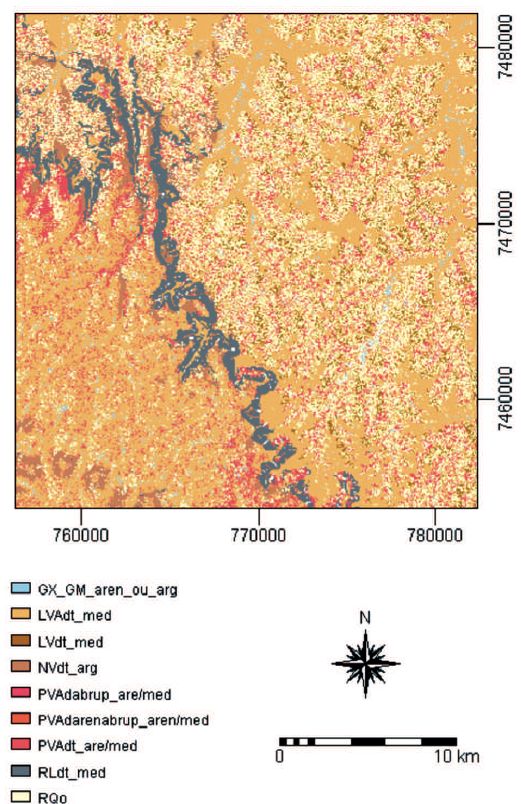
Figura 1. Mapa digital de solos da folha Botucatu, produzido a partir das variáveis geomorfométricas e litologia, por meio do algoritmo